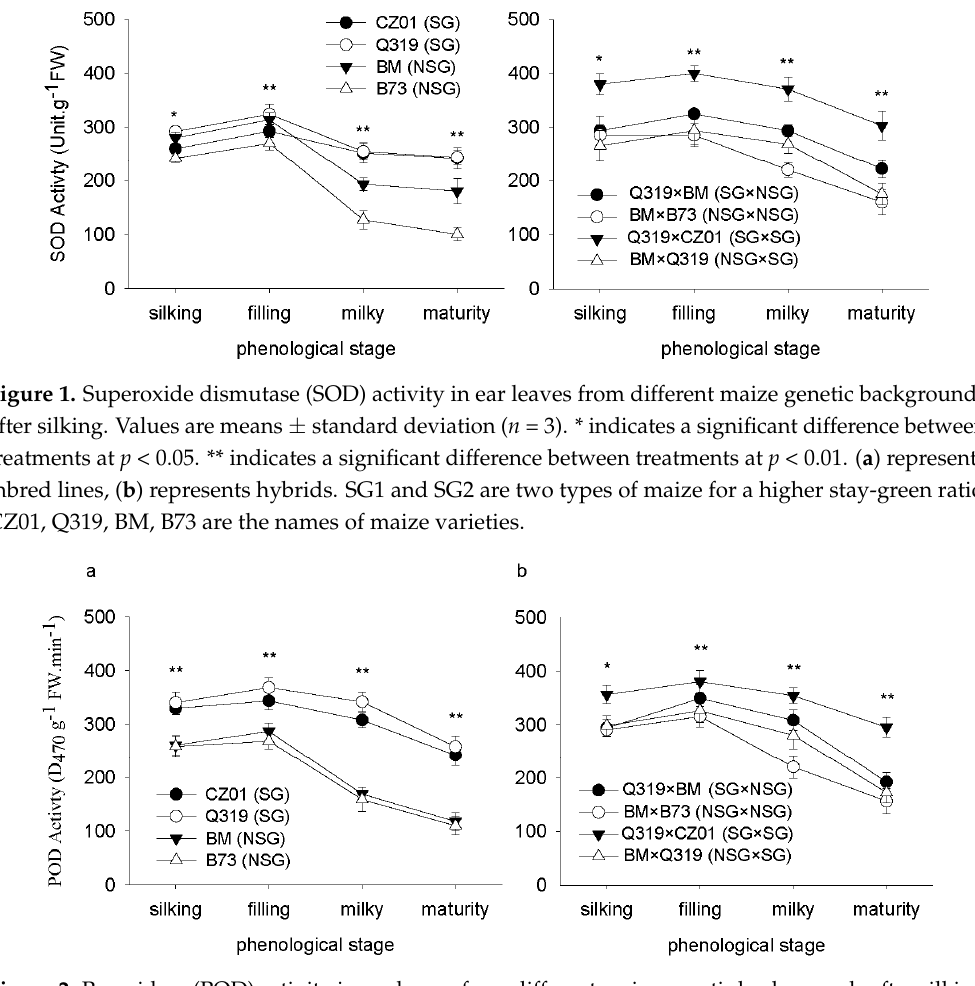
Figure 2. Peroxidase (POD) activity in ear leaves from different maize genetic backgrounds after silking. Values are means ± standard deviation ( n = 3). * indicates a significant difference between treatments at p < 0.05. ** indicates a significant difference between treatments at p < 0.01. The ( a ) represents inbred lines, ( b ) represents hybrids. SG1 and SG2 are two types of maize for a higher stay-green ratio; CZ01, Q319, BM, B73 are the names of maize varieties.